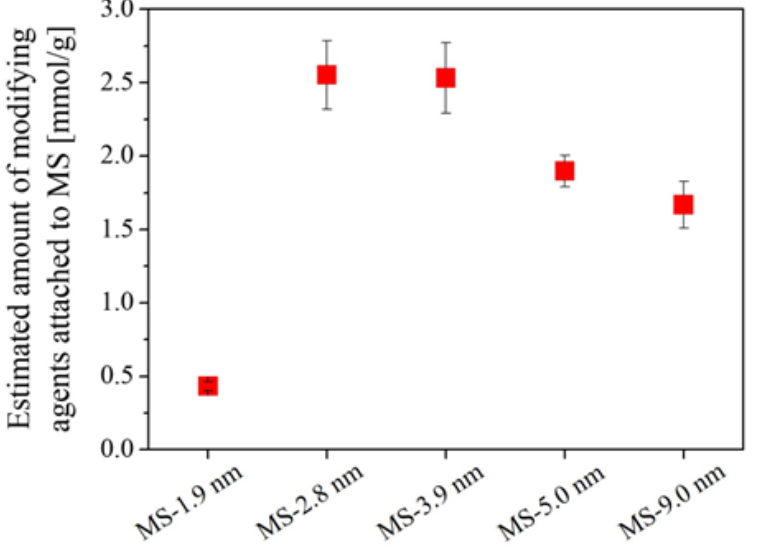
Figure 2. Amount of modifying agent embedded on MS with different pore sizes. Error bars indicate the standard deviation (± σ ).